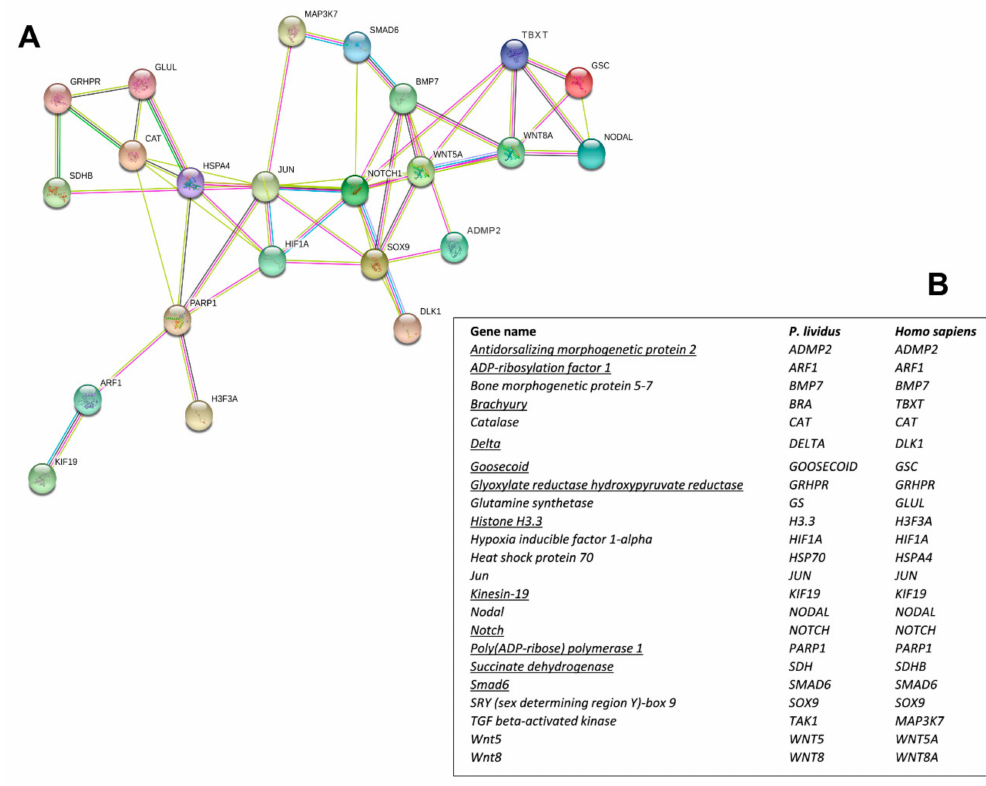
Figure 2. ( A ) Interactomic analysis by STRING (https: // string-db.org / ). The network graphically displays the relationship between genes. The biological relationships between genes are indicated by di ff erent colors. Known interactions: reported by database = light blue and determined experimentally = pink. Expected interactions: gene proximity = green; gene fusion = red; genes with similar pattern = light blue. ( B ) Homo sapiens gene names and the corresponding P. lividus orthologous genes. The new genes isolated in the present work are